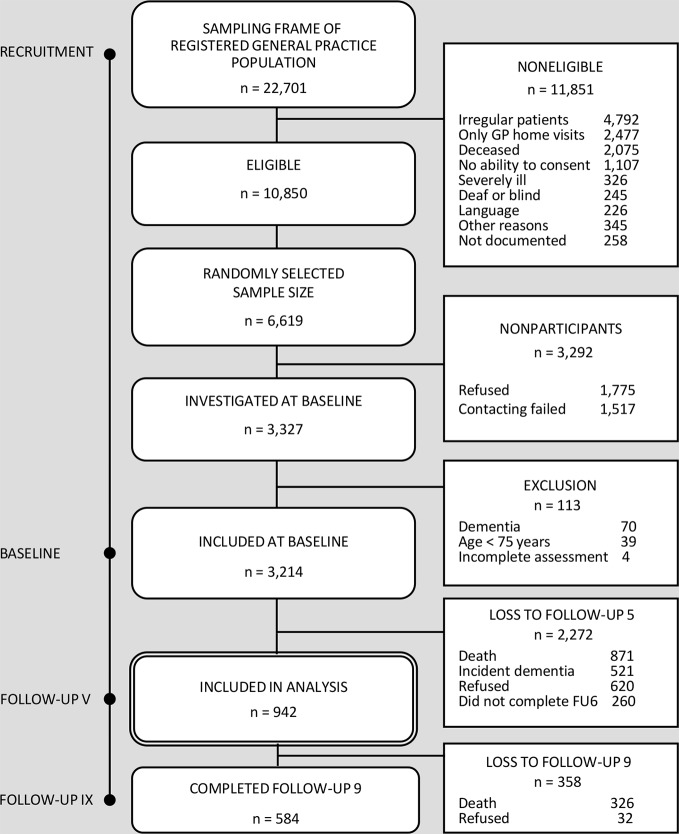
Flowchart - recruitment and analytical sample selection of the German study on aging, cognition, and dementia in primary care patients (AgeCoDe)/the study on needs, health service use, costs, and health-related quality of life in a large sample of oldest-old primary care patients (AgeQualiDe).